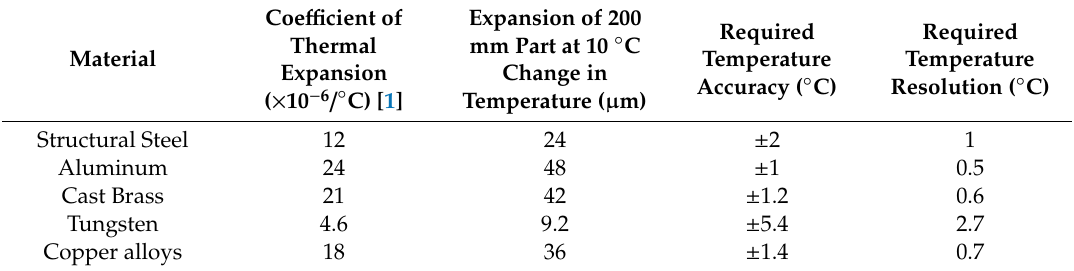
Table 1. Required accuracy and resolution for the precision manufacturing of di ff erent materials.